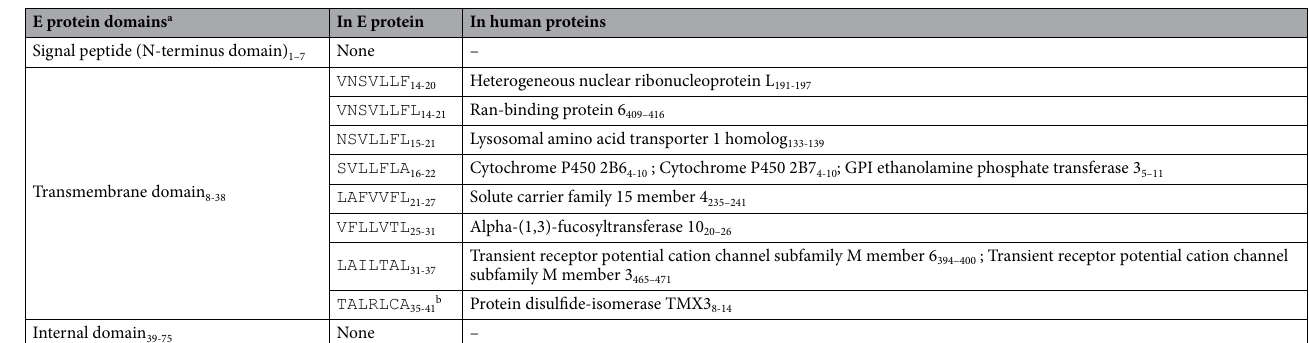
Table 2. Localization of homologous 7-/8-mers in the E protein and human proteins. a Domain boundaries see in 8 . b Heptamer TALRLCA 35-41 is located at the junction of the transmembrane domain 8-38 and internal domain 39-75